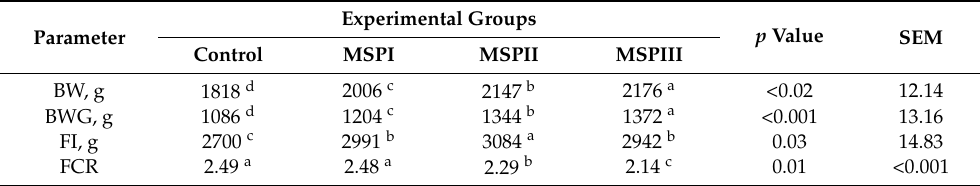
Table 3. Effect of various levels of multi-strain probiotics supplementation on growth performance attributes of rabbits at the end of the growing period (60 d).